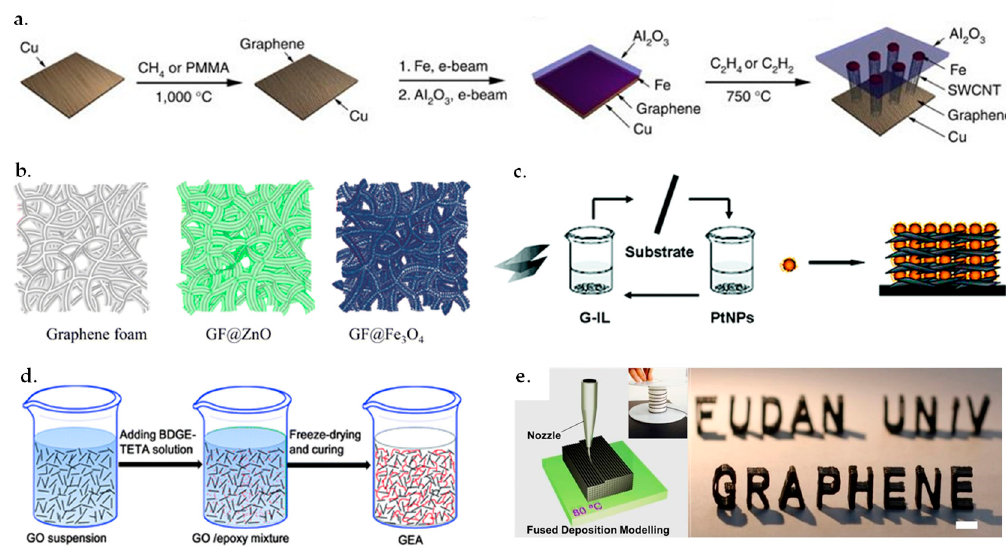
Figure 1. Fabrication strategies of three-dimensional (3D) graphene-based hybrid materials (GBHMs) ( a , b ) templated synthesis. Reproduced from [40,47], with permission from Nature Publishing Group, 2012 and American Chemical Society, 2013. ( c ) Self-assembly fabrication. Reproduced from [41], with permission from American Chemical Society, 2010. ( d ) Freeze drying. Reproduced from [42], with permission from Royal Society of Chemistry, 2013. ( e ) 3D printing. Reproduced from [43], with permission from Nature Publishing Group, 2015.